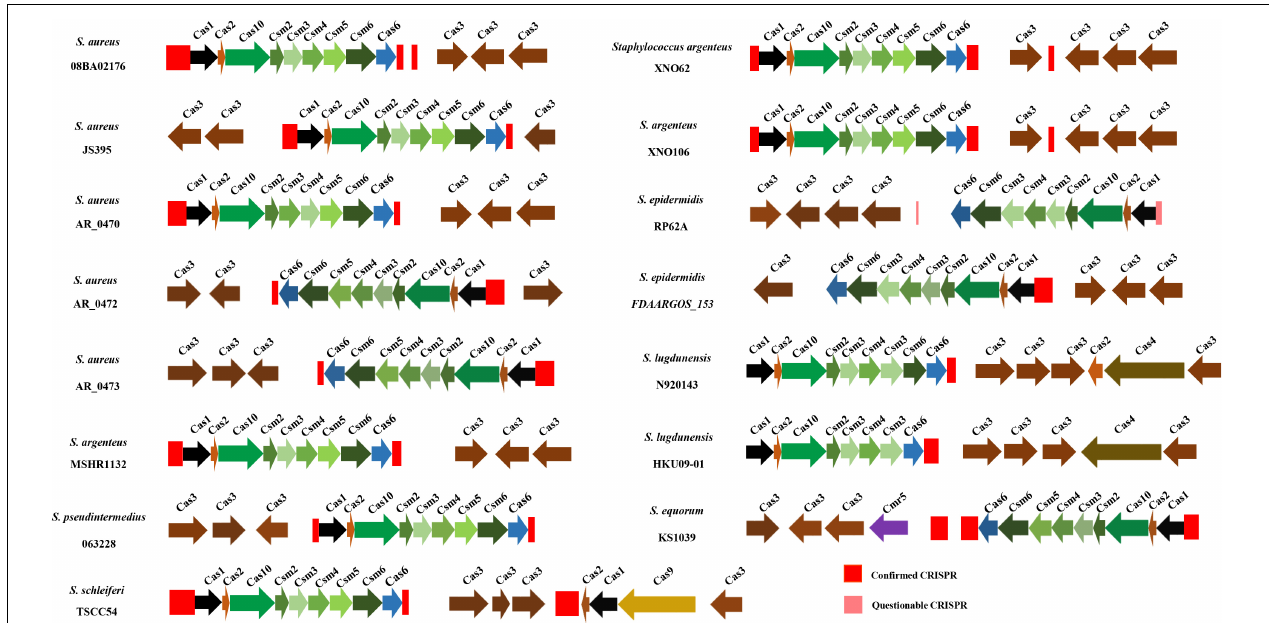
FIGURE 5 | The distribution of CRISPR and cas genes in 15 Staphylococci . The red and pink rectangles represent confirmed CRISPRs and questionable CRISPRs, respectively.